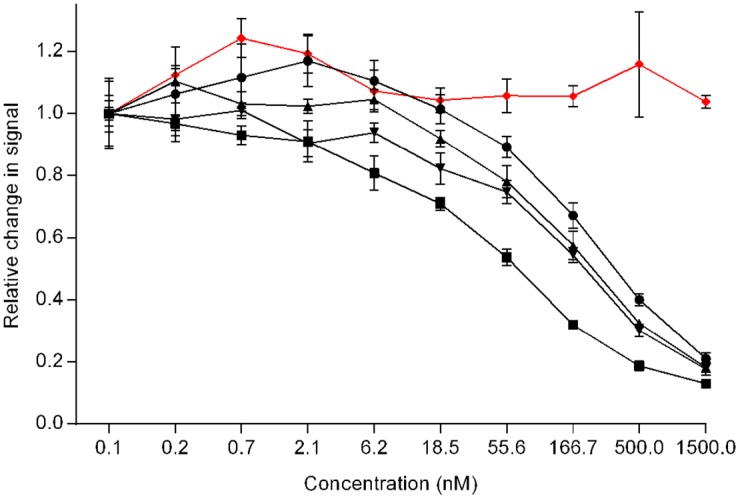
Binding of glycovariants to FcγRIIIa, expressed on living cells.Unlabeled glycovariants compete for binding to receptor with acceptor-labeled antibody, resulting in decrease of FRET signal: deglycosylated (red diamonds), WT (black circles), G0 (black triangles), G1(black inverted triangles), G2 (black squares). Initial signal was normalized to 1. (For remaining glycovariants refer to S3 Fig).